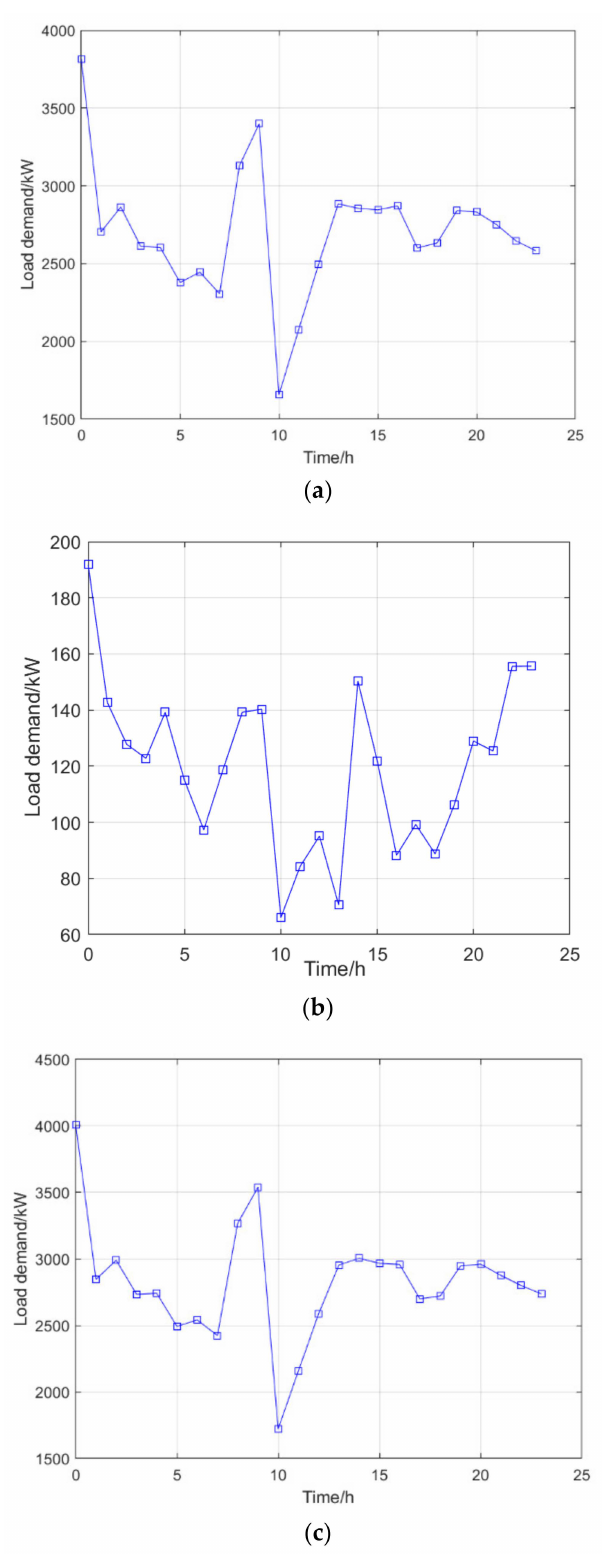
Figure 21. Fast charging demand load at 200 electric taxis. ( a ) Charging demand generated by electric taxis in charging stations. ( b ) Charging demand for electric taxis at their current location. ( c ) Charging needs generated by electric